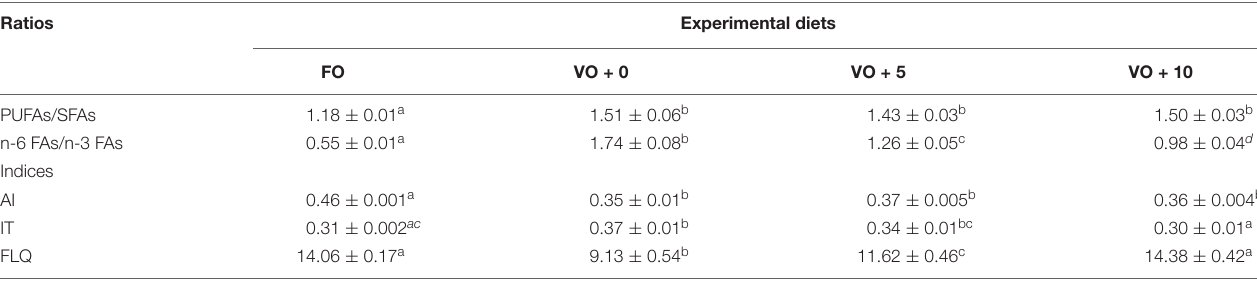
FIGURE 1 | Profile of the main FAs in filets of fish fed with the four different experimental diets. The values are expressed as g/100g of the total fat fraction and are reported as mean ± SEM ( n = 6). Different letters indicate significant differences between experimental diets as determined by one-way ANOVA with Tukey’s comparison test ( p < 0.05). TABLE 8 | Fatty acids ratios and nutritional indices of filets from fish fed with the four experimental